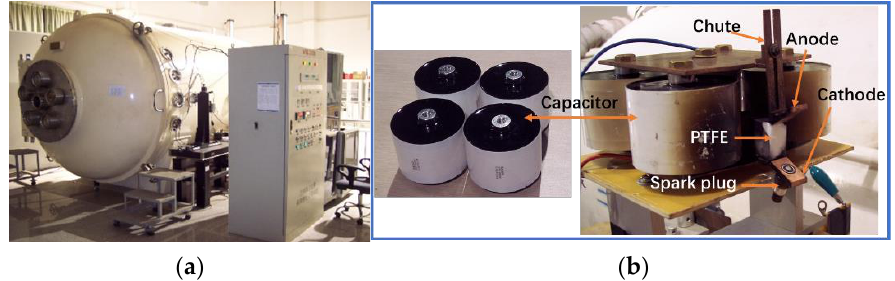
Figure 1. ( a ) Vacuum chamber and ( b ) the APPT used in the experiment.